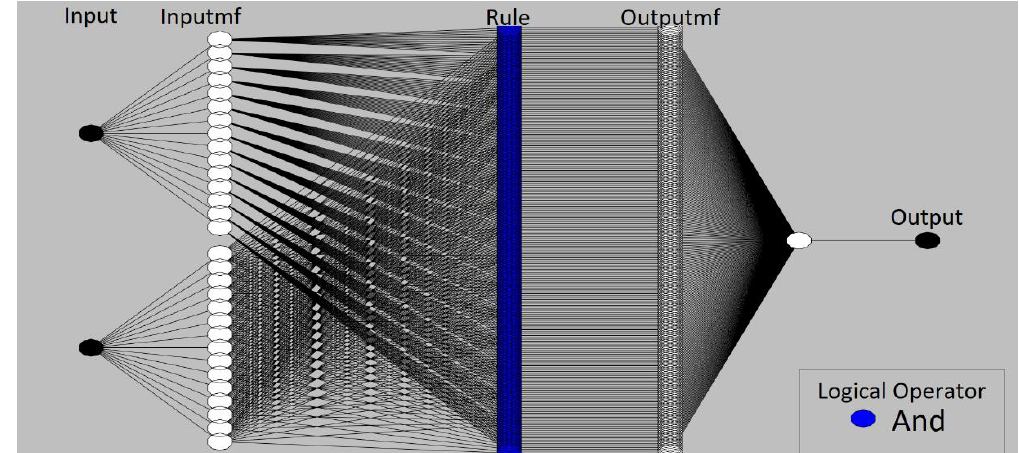
Figure 5. ANFIS multilayer architecture.